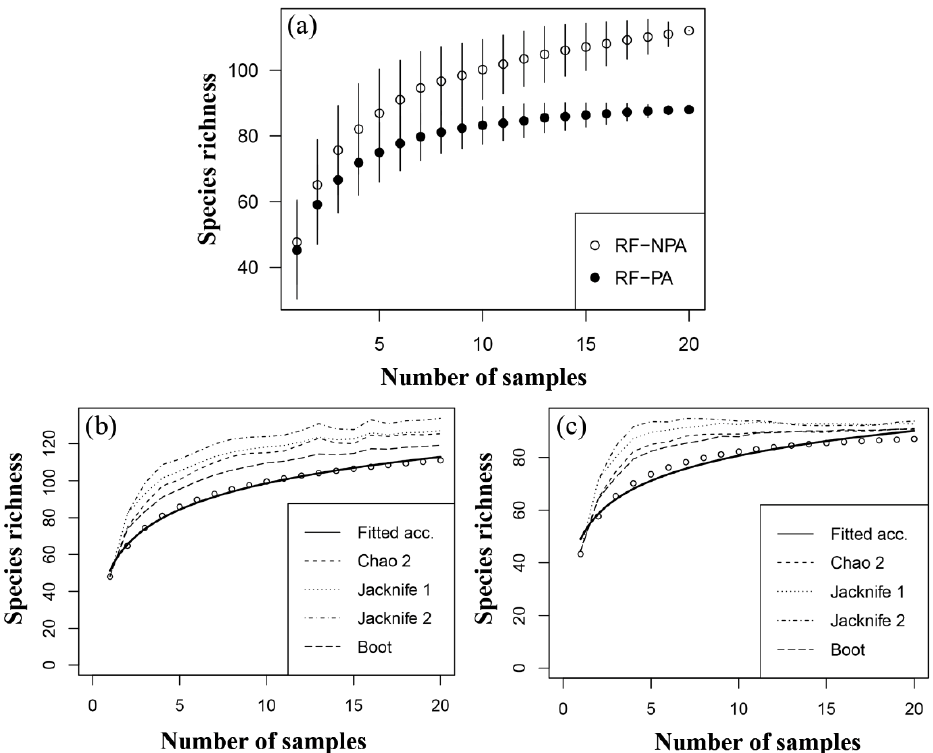
Figure 4. Species accumulation curve ( a ), and the estimation curves of zooplankton in RF-NPA ( b ) and RF-PA ( c ). The mean zooplankton density in RF-NPA was significantly higher than that in RF- PA ( p < 0.001) (24.4 and 16.6 ind./L, respectively). The total densities of the RF-NPA zooplankton at the first and second samplings were 250.3 and 238.1 ind./L, respectively. By comparison, the corresponding figures for RF-PA were lower (179.4 and 153.1 ind./L, respectively). The first sampling in RF-PA showed significantly higher average cladoceran and nauplii densities than the second sampling (Table 3). Table 3. The mean ± SD of the density and range of relative density of zooplankton in RF-NPA and RF-PA on two sample occasions. The asterisks (*) indicate statistically significant differences. RF-NPA Zooplankton